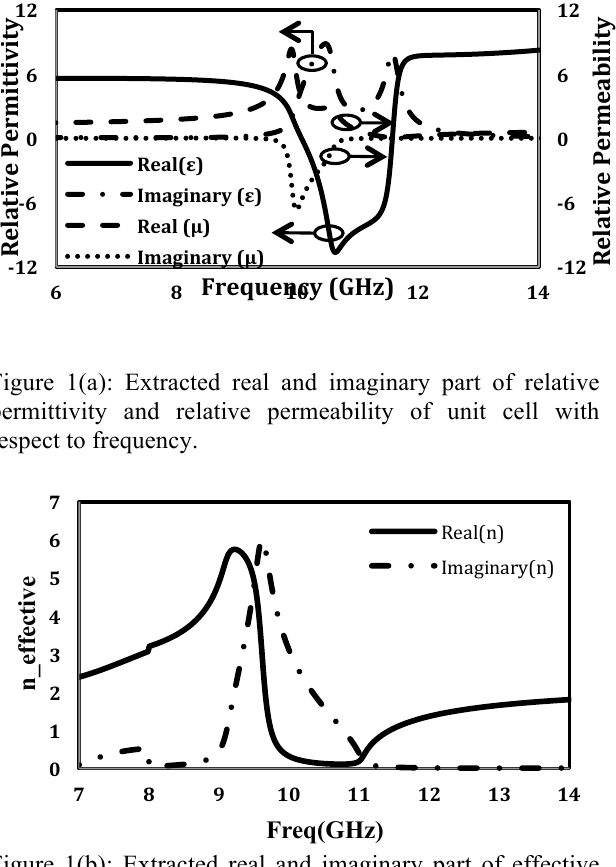
Figure 1(b): Extracted real and imaginary part of effective refractive index of unit cell with respect to frequency.